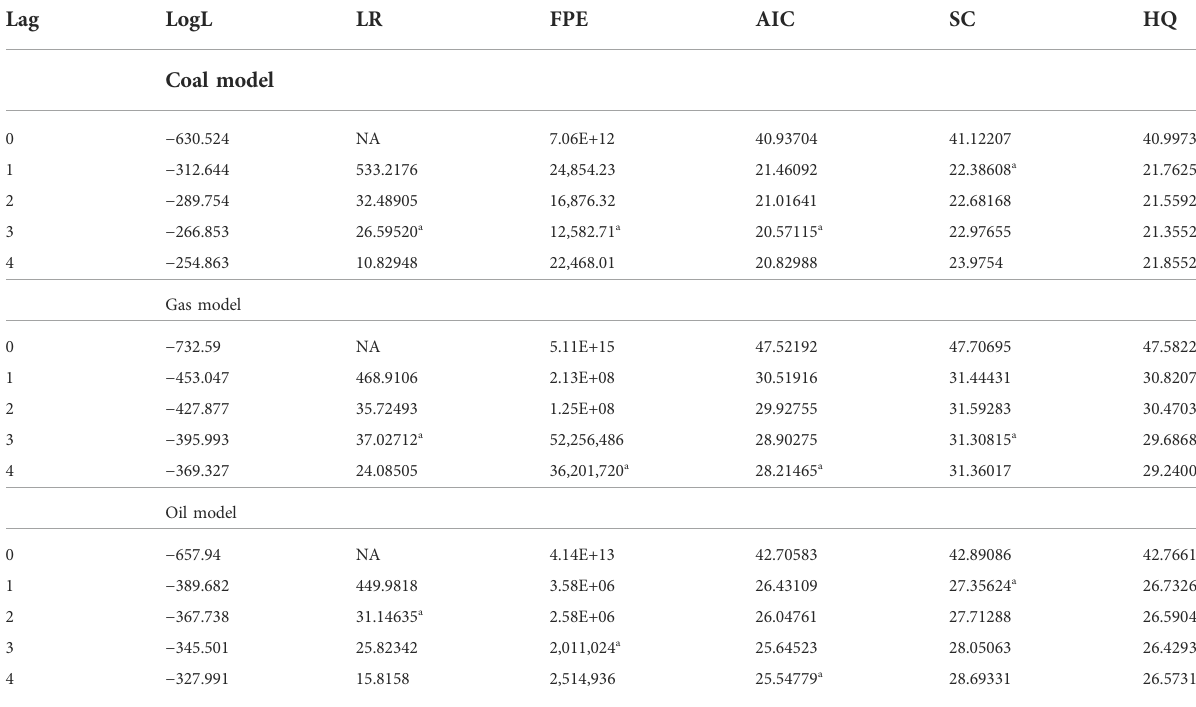
TABLE 2 Results for the optimal lag length for each